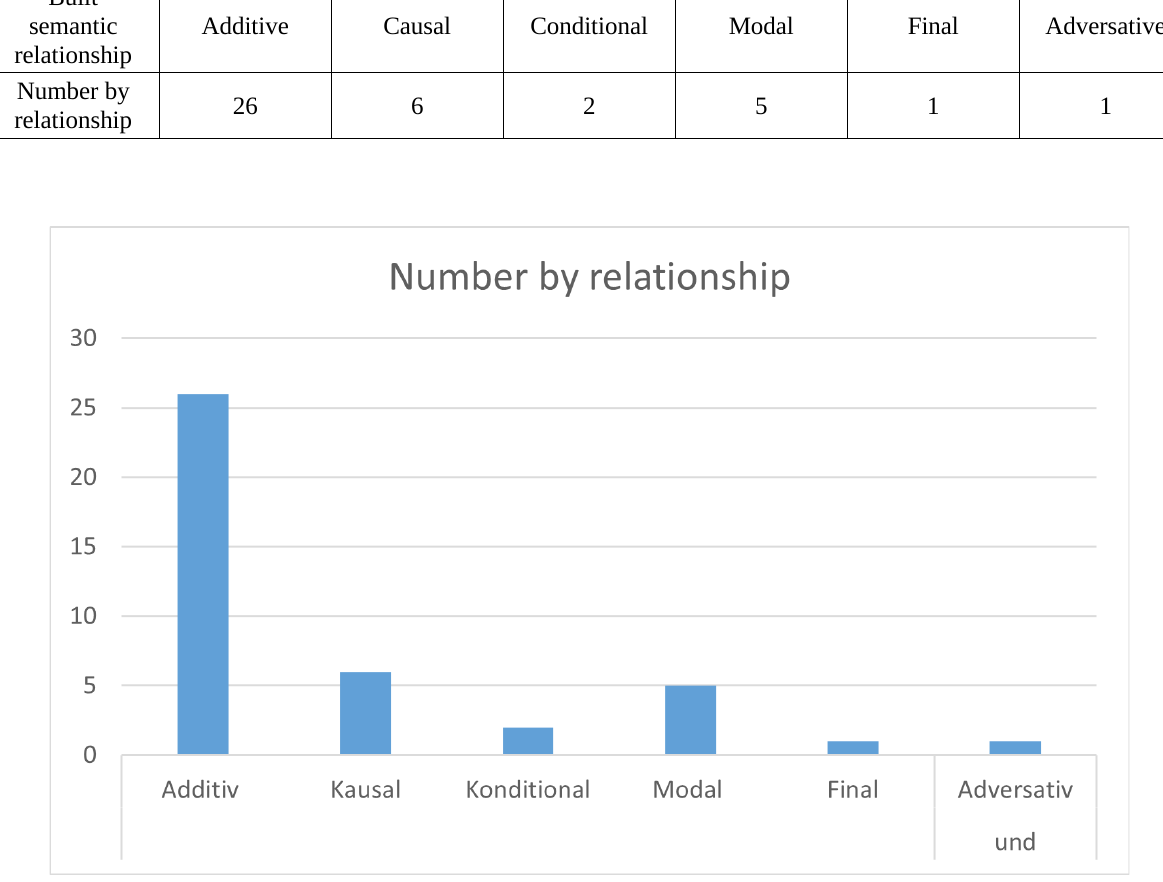
Figure 2 - Semantic variants of the additive